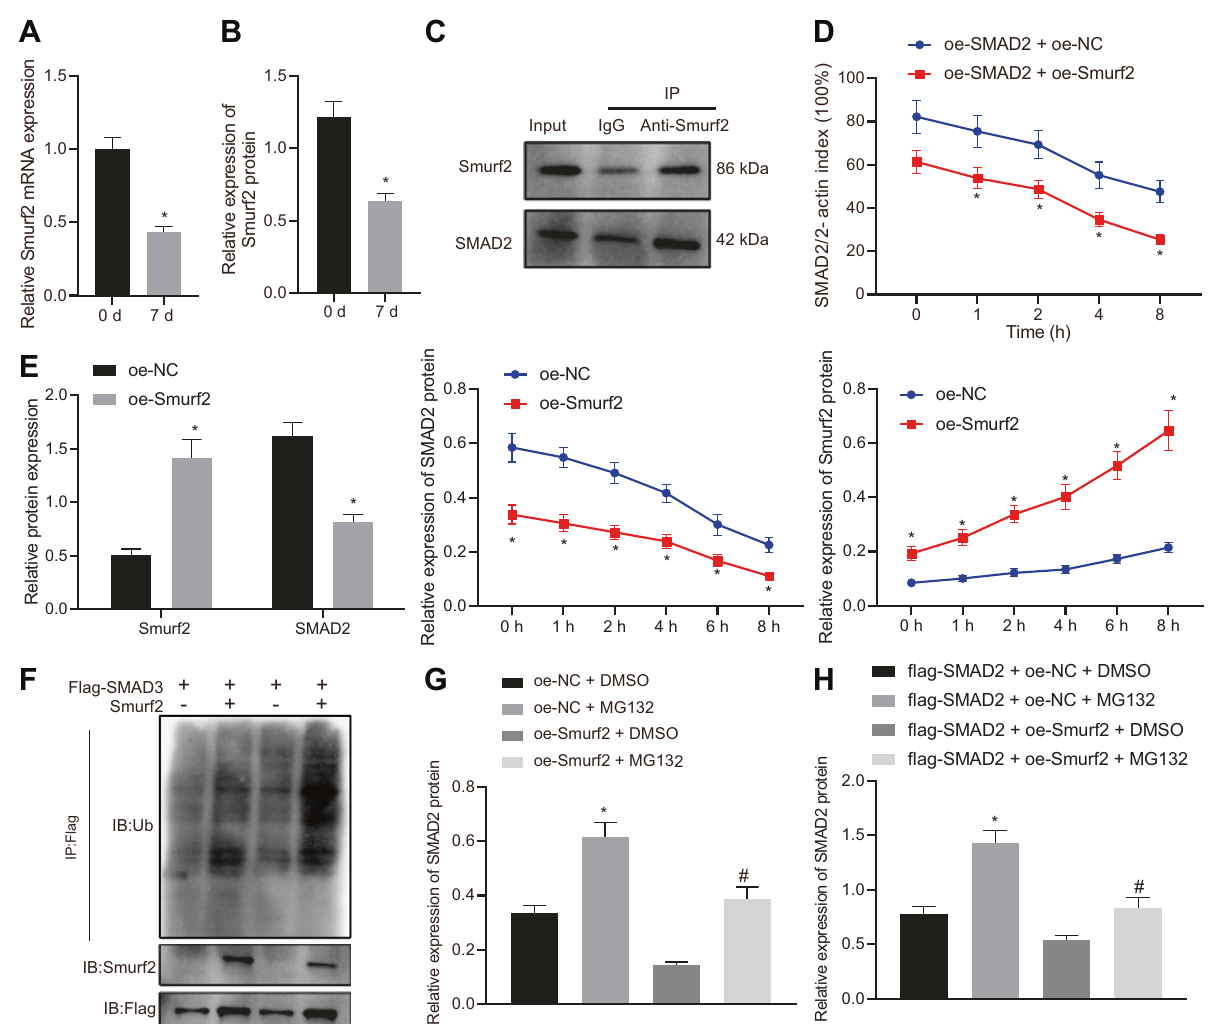
Fig. 2 Smurf2 degrades SMAD2 through ubiquitination and then downregulates its expression. Smurf2 mRNA ( A ) and protein ( B ) levels in HFSCs after 7-day differentiation determined by RT-qPCR and western blot assay, with β -actin as internal reference, * p < 0.05 vs. day 0. C Interaction between Smurf2 and SMAD2 in HFSCs identi fi ed by IP. D Stability of SMAD2 protein in response to Smurf2 overexpression in HEK293 cells treated with cycloheximide for 1, 2, 4, 6, 8 h. * p < 0.05 vs. oe-SMAD2 + oe-NC group. E SMAD2 protein level in HFSCs overexpressing Smurf2 measured by western blot assay, with β -actin as internal reference, * p < 0.05 vs. oe-NC grou p . F Ubiquitination of SMAD2 in HFSCs after Smurf2 overexpression determined by IP (IB-Ub refers to ubiquitinated antibody used in immunoblot, while IB-SMAD2 refers to SMAD2 antibody used in immunoblot). G The ubiquitination of SMAD2 in HFSCs treated with proteasome inhibitor MG132 or DMSO alone or in the presence of Smurf2 determined by IP. * p < 0.05 vs. oe-NC + DMSO group; # p < 0.05 vs. oe-Smurf2 + DMSO group. H The ubiquitination of SMAD2 in HFSCs in response to MG132 treatment and SMAD2 overexpression or in the presence of Smurf2 determined by IP. * p < 0.05 vs. fl ag-SMAD2 + oe-NC + DMSO group; # p < 0.05 vs. fl ag-SMAD2 + oe-Smurf2 + DMSO group. Data are expressed as mean ± standard deviation. Data comparison between two groups was performed by unpaired t test, while data between multiple groups were compared by one-way ANOVA wi t h Tukey ’ s post hoc test. Data at different time points were compared by two-way ANOVA with Bonferroni post hoc test. Each cell experiment was repeated 3 times. overexpressing both Smurf2 and SMAD2, MG132 treatment was found to further elevate the protein levels of SMAD2 (Fig. 2H), suggesting that MG132 inhibited the Smurf2-mediated ubiquiti- nation and degradation of exogenous SMAD2. Together, these fi ndings indicated that Smurf2 could degrade SMAD2 through ubiquitination and then downregulate its expression. Smurf2 degrades SMAD2 to inhibit the HFSC differentiation and induce cell proliferation The effect of Smurf2-mdeiated degradation of SMAD2 through ubiquitination on the function of HFSCs was the next focus of this study. The results of RT-qPCR and western blot assay showed no